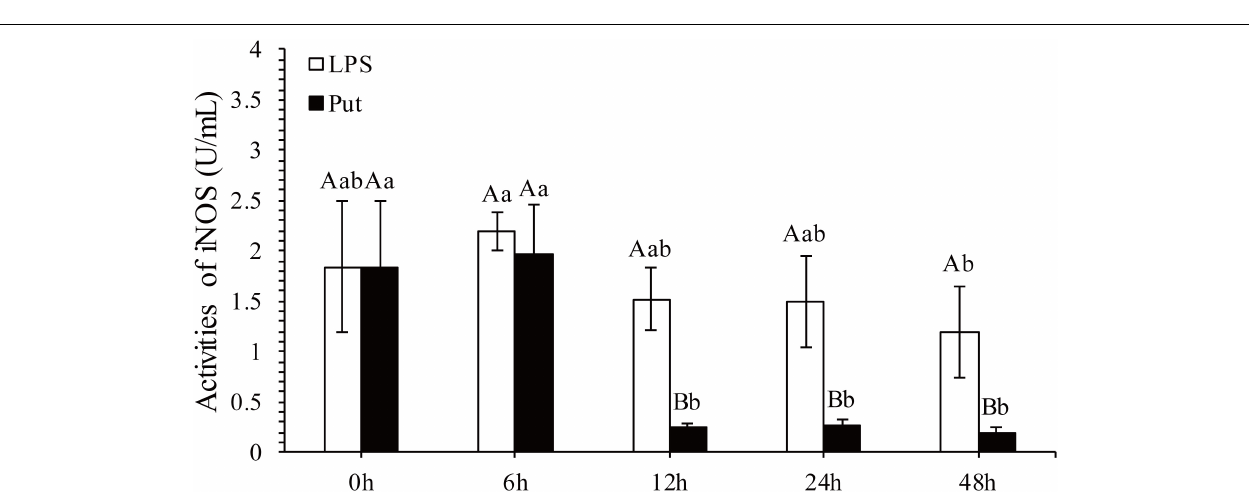
Frontiers in Physiology |